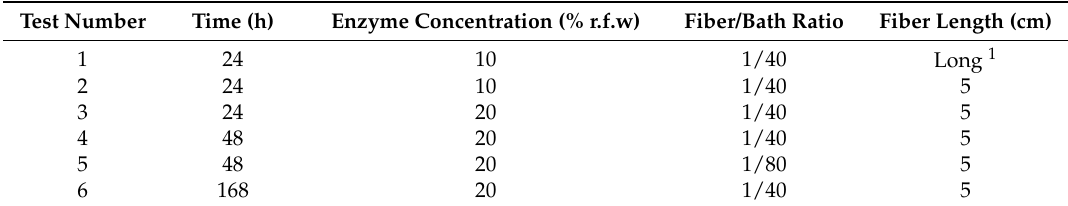
Table 2. Tests to determine limit conditions for Biopectinase K.